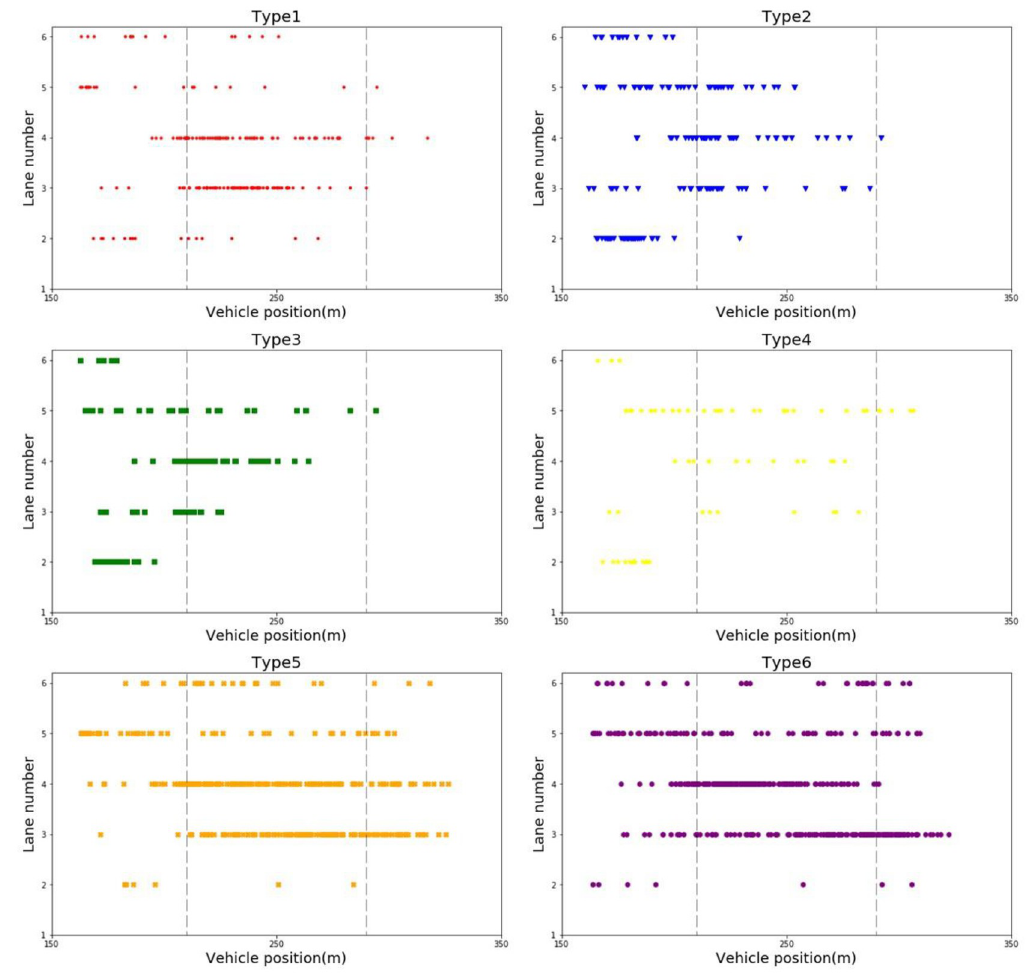
Fig 10. The distribution of the six environment types in the weaving